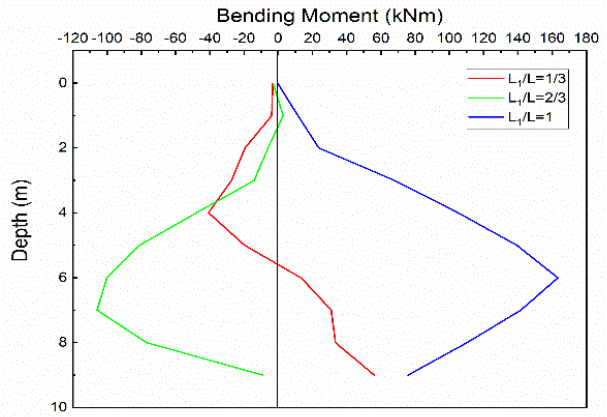
Figure 7. Bending moment simulation of distributions of in existing free-head pile caused by driving of a pile